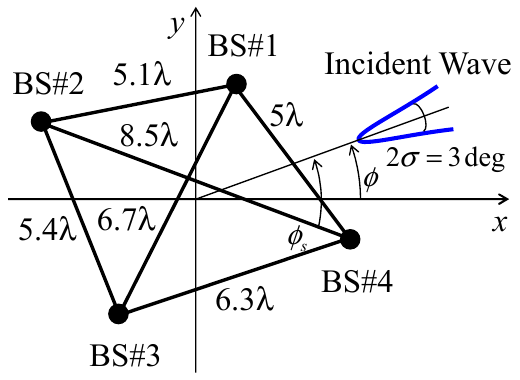
Figure 5. Arrangement of the BS antennas.